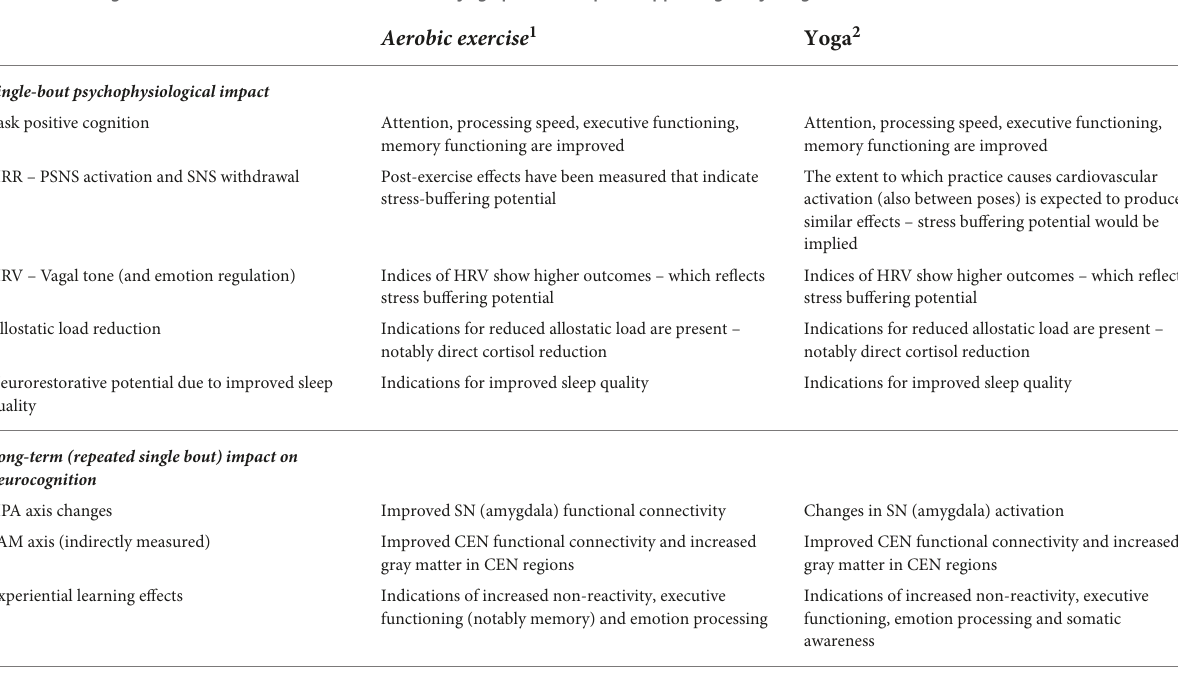
TABLE 1 PE augmented mindfulness: aerobic exercise or yoga practice impact supporting early-stage